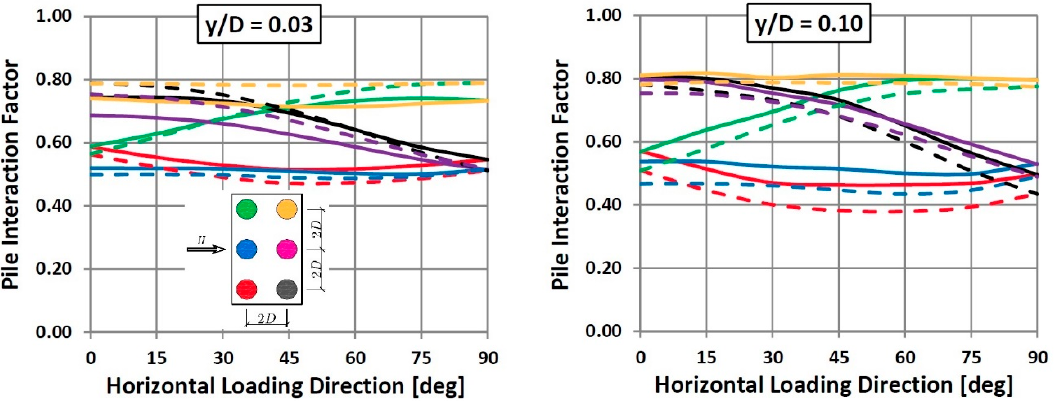
Figure 12. Pile interaction factors for rectangular 2 × 3 pile group ( s x = 2 D , s y = 2 D ). Different colors denote piles inside the pile group. Full lines—loose sand; dashed lines—dense sand.